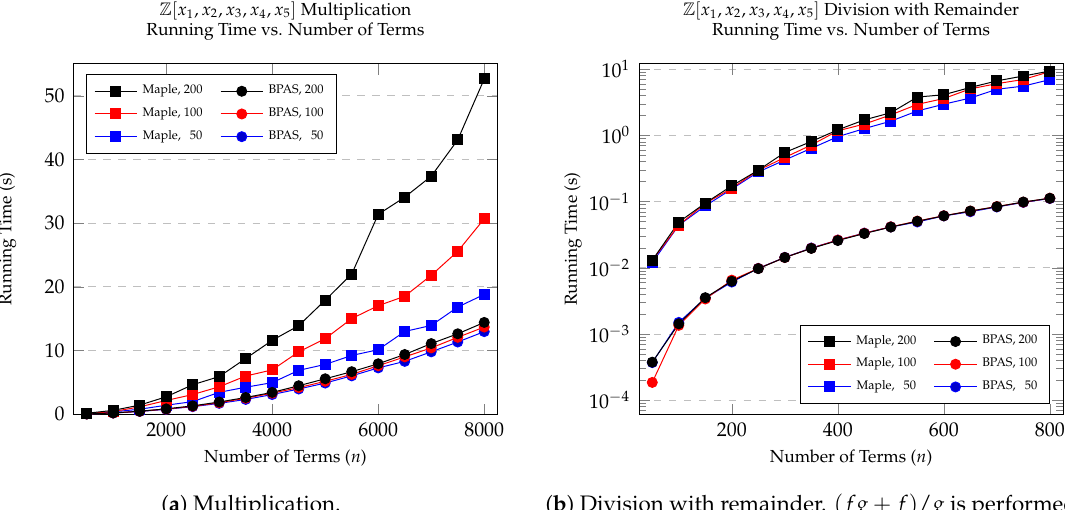
Figure 6. Comparing multiplication and division with remainder over Z . Polynomials are in 5 variables and the coefficient bound is 128. The sparsity varies as noted in the